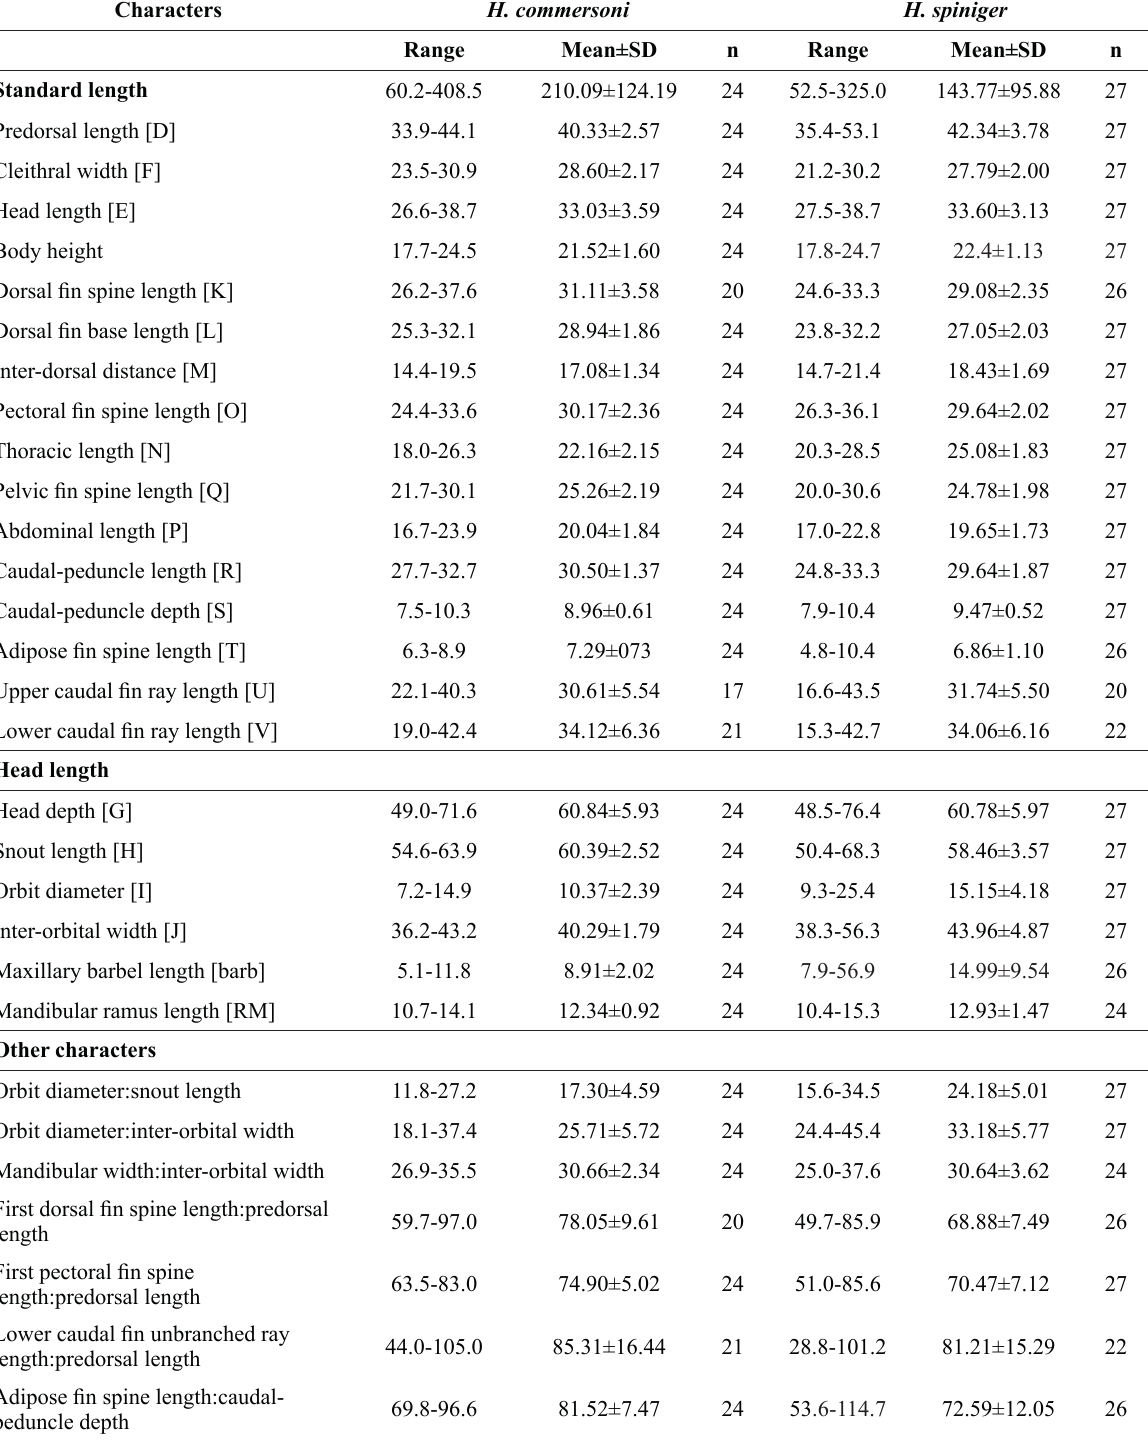
Morphometric and meristic data of Hypostomus commersoni and H. spiniger . Range, mean (or mode for the meristic data), standard deviation (SD) and number of specimens (n). Morphometric and meristic variables used in the BCA analysis (Figs. 3 and 4) are showed with abbreviations in squared